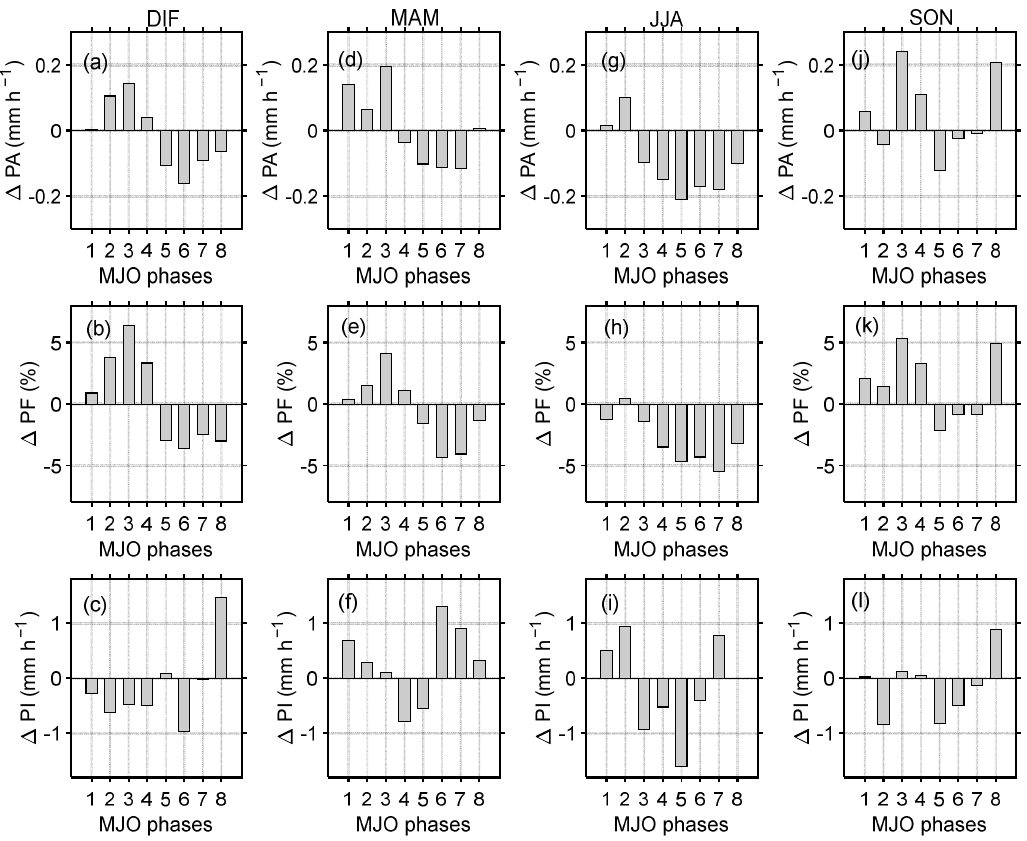
Figure 9. Same as Figure 7( d–f ), but for DJF ( a−c ), MAM ( d−f ), JJA ( g−i ), and SON ( j−l ) periods.